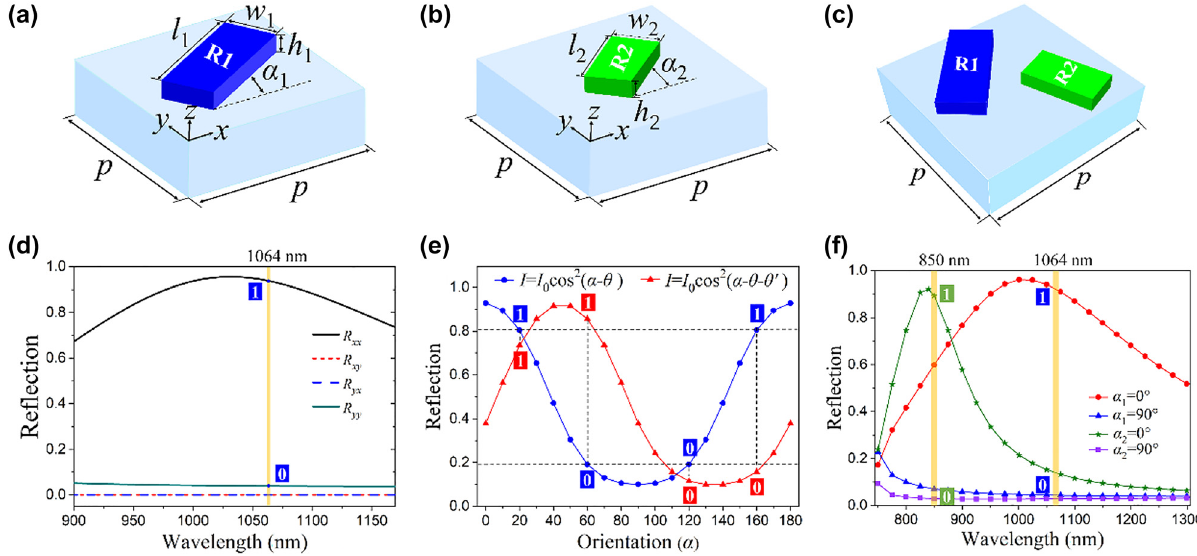
Figure 2: Schematics of unit cells and principle of encoded display metasurface. substrate. (d) Principle of reflection amplitude encoded (a, b, c) Schematics of unit cells of single- and double-nanorod on SiO 2 single-channel display metasurface. The simulated reflection of different LP components from a metasurface composed of R1 nanorods with 𝛼 = 0 ◦ . (e) Principle of polarization encoded multiplexed display metasurface. The reflection intensities in channels 1 and 2 satisfy I = I 0 cos 2 ( 𝛼 - 𝜃 ) (blue curve) and I = I 0 cos 2 ( 𝛼 - 𝜃 - 𝜃 ′ ) (red curve), respectively, where 𝛼 is the orientation angle of each nanorod, 𝜃 is the original angle of polarizer for channel 1, 𝜃 ′ is the rotated angle of polarizer for channel 2. The curve shows that an identified orientation angle of nanorod can realize the intensity contrast of two polarization-encoded channels, for two polarization angles 𝜃 and 𝜃 - 𝜃 ′ , there are four orientation angles in the orientation interval [0, 𝜋 ], which can be regarded as the candidates for two-channel polarization encoded metasurface. (f) The principle of wavelength encoded display metasurface, which provides two channels at 1064 nm and 850 nm when the polarization angle along the long axis of the